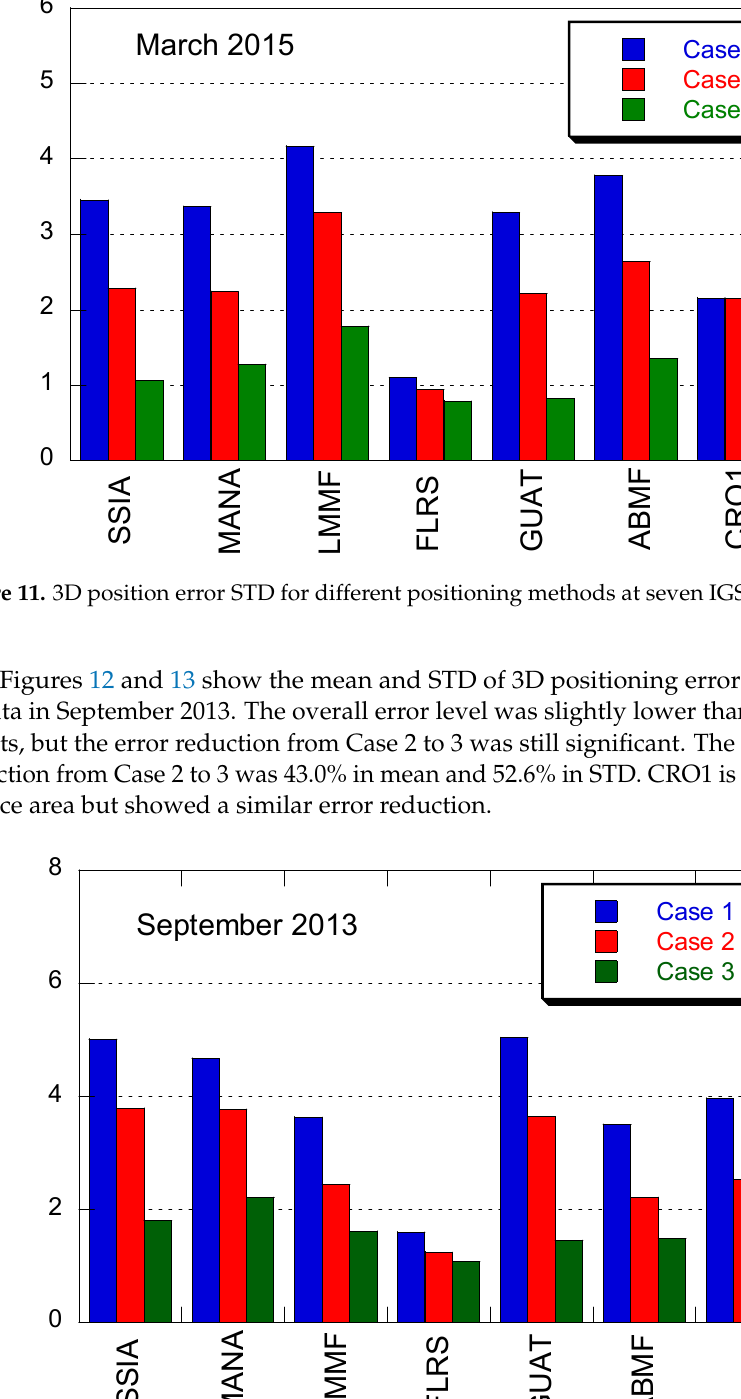
Figure 10. 3D position error mean for different positioning methods at seven IGS stations in March 2015.